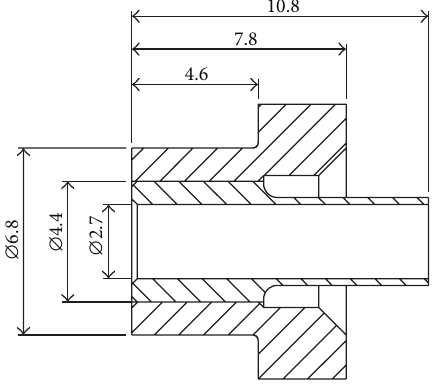
Figure 1: Geometric model (units: mm).